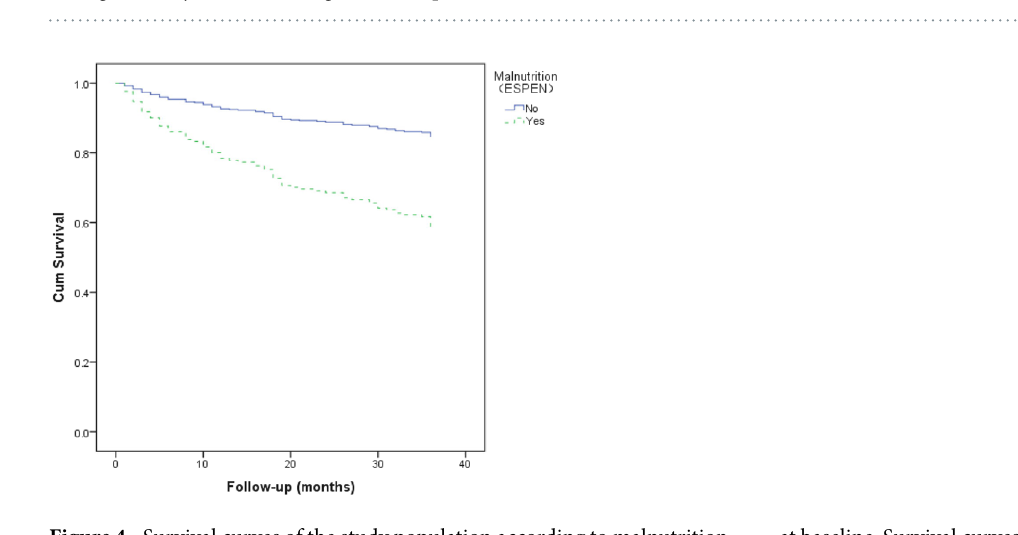
Figure 3. Survival curves of the study population according to malnutrition MNA at baseline. Survival curves did not significantly differ in the log-rank test (p = 0.094).